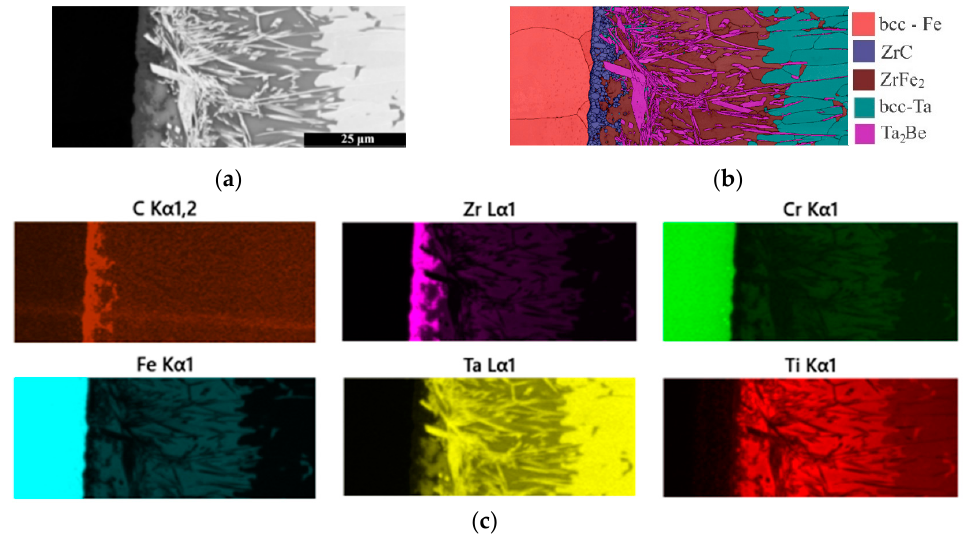
Figure 7. SEM analysis of Rusfer/ TiZr4Be/Ta seam: ( a ) backscattered electron image; ( b ) EBSD phase map; ( c ) EDS distribution maps.